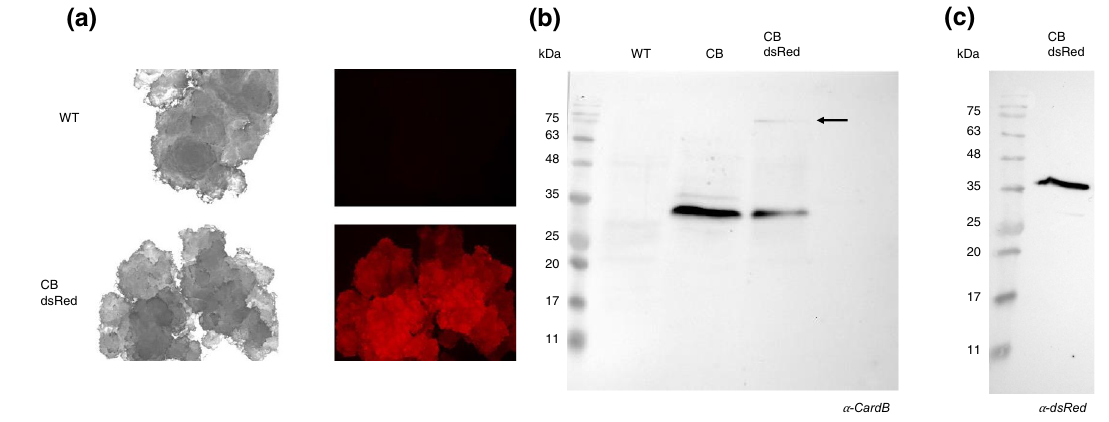
Figure 4. Analysis of CardB-dsRed fusion lines. ( a ) Fluorescence stereoscope visualization of WT and CardB- dsRed calli ( b ) Western blot analysis with anti-cardosin B antibody of WT, CardB and CardB-dsRed cellular extracts ( c ) Western blot analysis with anti-dsRed antibody of CardB-dsRed cellular